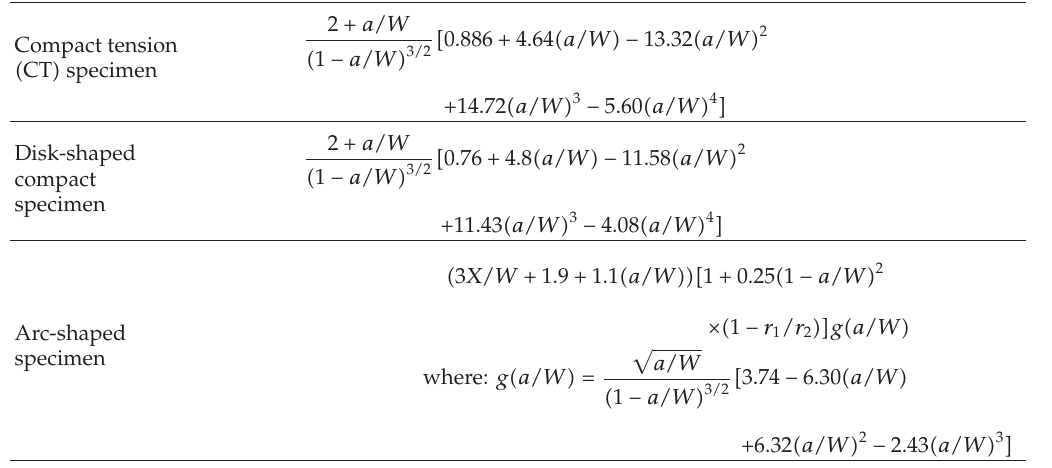
Table 4: f (cid:2) a/W (cid:3) for surface loaded specimens (cid:6) 23 (cid:7)